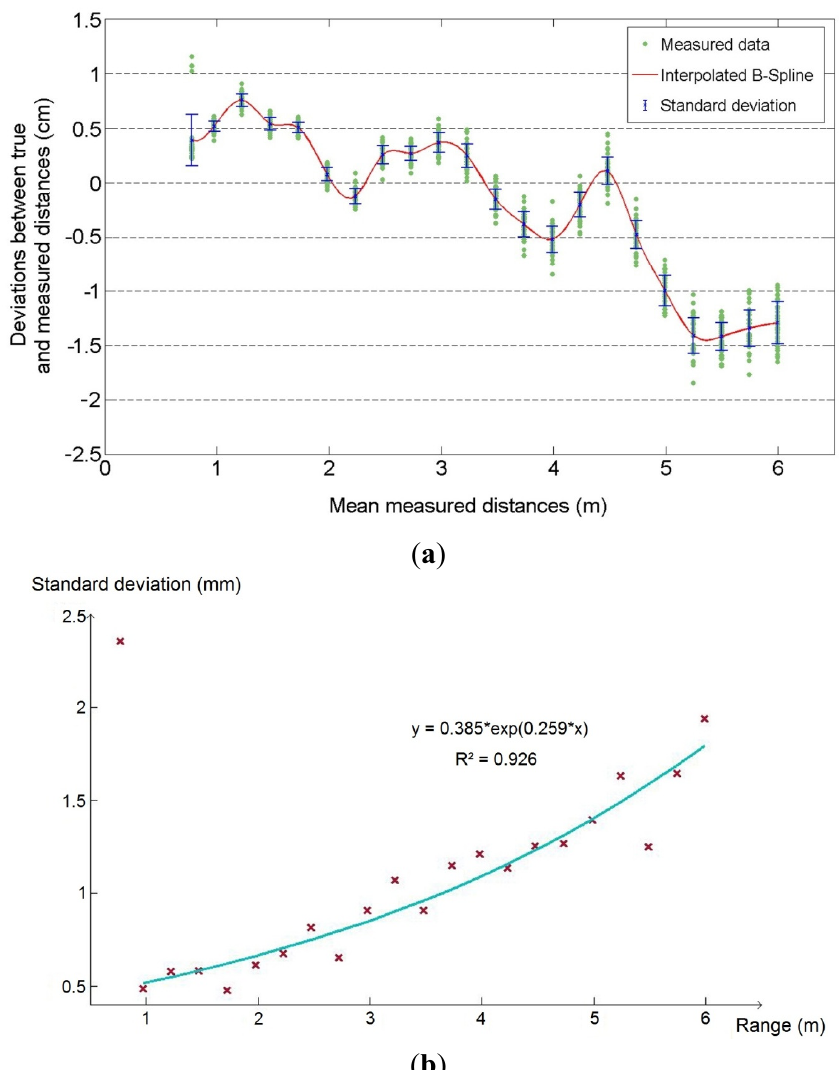
Figure 7. ( a ) Deviations (in cm) between true distances and measured distances, as a function of the range (m). ( b ) Evolution of the standard deviation (in mm) calculated over each sample of 50 measurements, as a function of the range